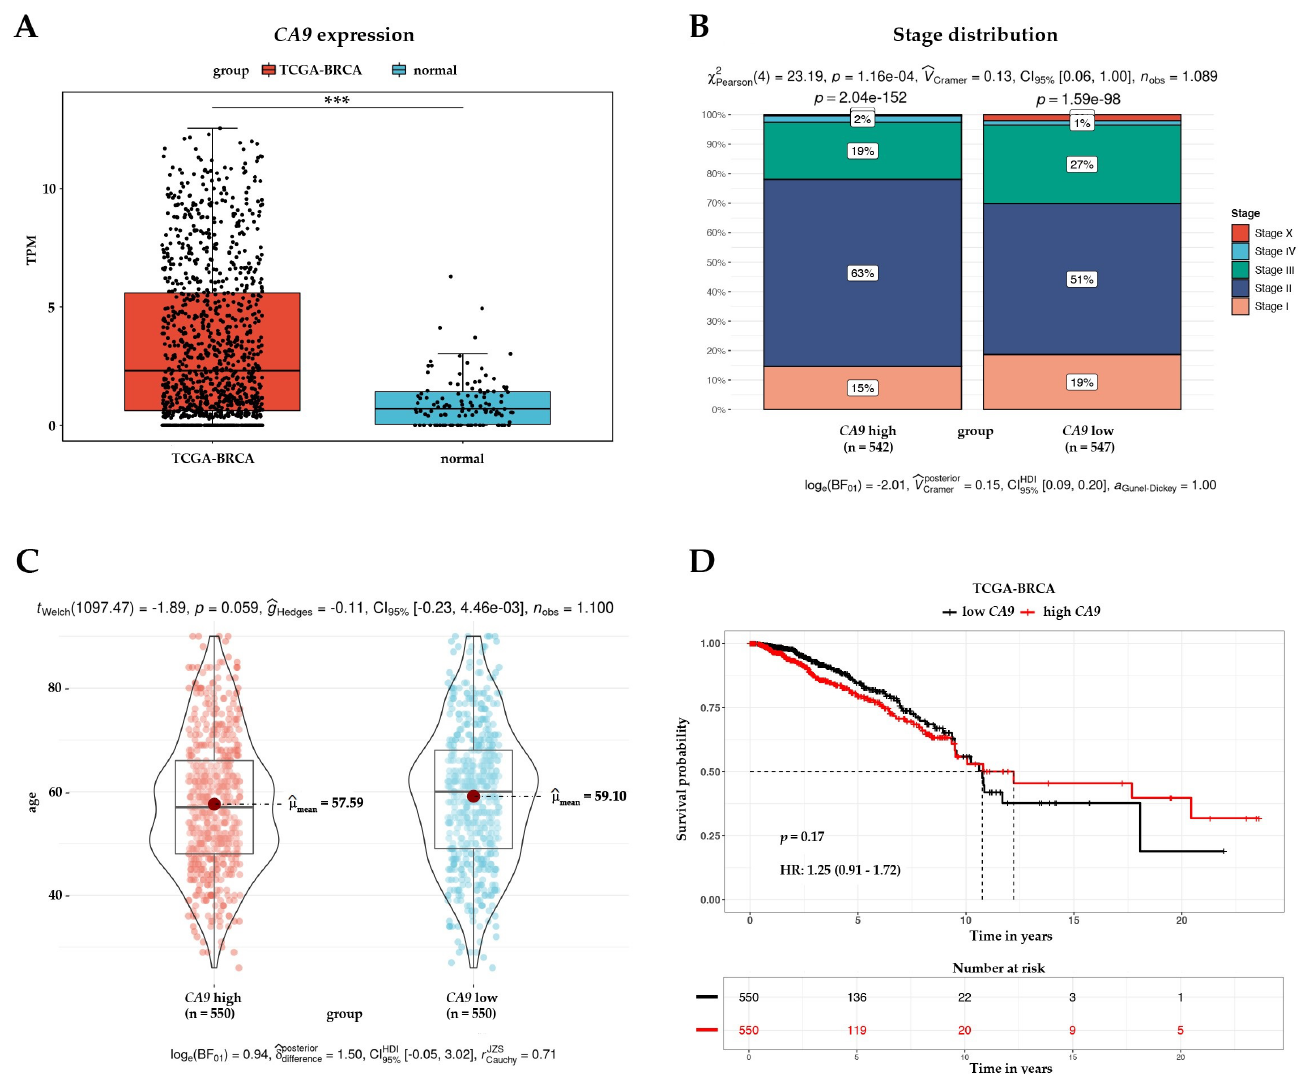
Figure 5. Analysis of CA9 gene expression in the TCGA-BRCA dataset. ( A ) Differential expression between tumor and normal tissue presented as a boxplot for the two groups. The Wilcox test was performed to test whether there was a significant difference between the two groups. *** p < 0.001. Stage distribution ( B ) and age at initial pathologic diagnosis ( C ) are presented based on the expression status of the CA9 gene; ( D ) univariate analysis presented as a Kaplan–Meier (KM) survival plot includes the p -value ( p = 0.17 ) and hazard ratio with 95% confidence interval